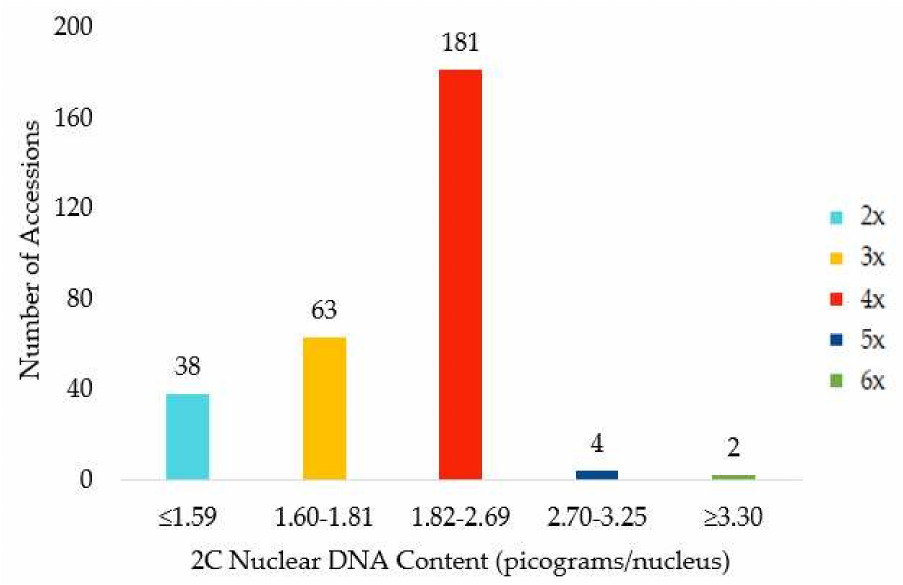
Figure 3. Nuclear DNA content (pg) of 288 accessions of bermudagrass from the USDA collection determined through flow